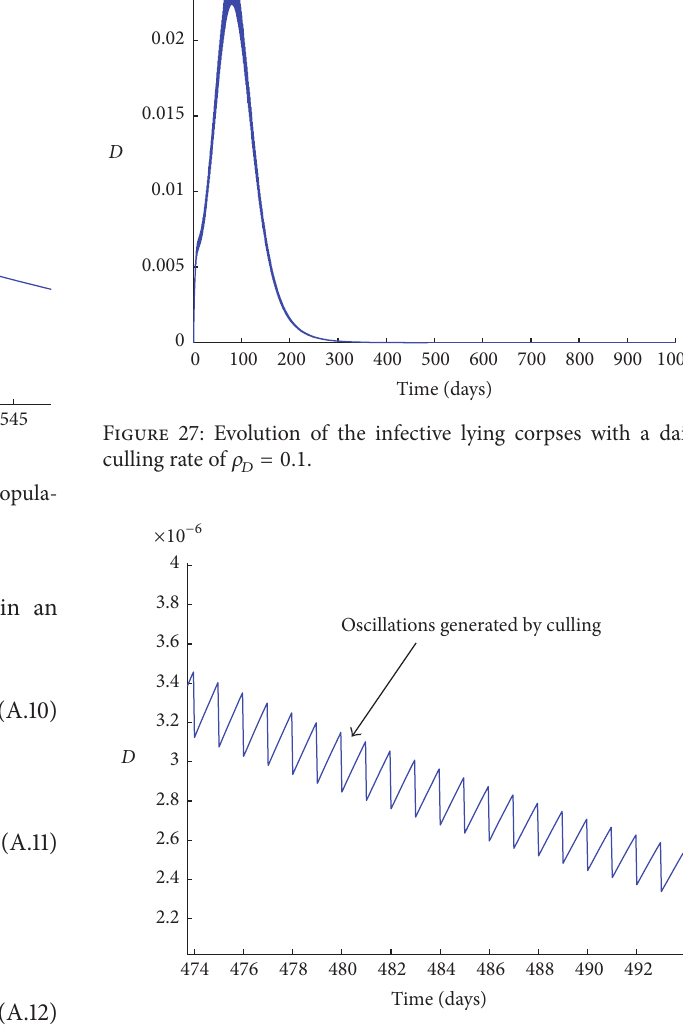
Figure 28: Zoom on the evolution of the infective corpses with a daily culling rate of 𝜌 𝐷 = 0.1